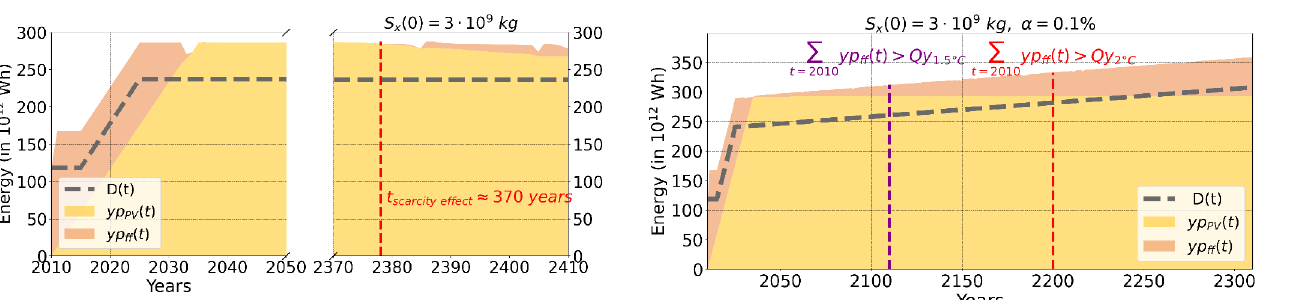
Fig. 11. French energy mix following the scenario D, with t f = 400 years and with S x (0) = 3 billion kilograms. Purple and red vertical dashed lines respectively define dates, 2110 and 2200, for which total fossil fuel consumption overtakes power generation carbon budget of France to maintain global warming below 1 . 5 and 2 ◦